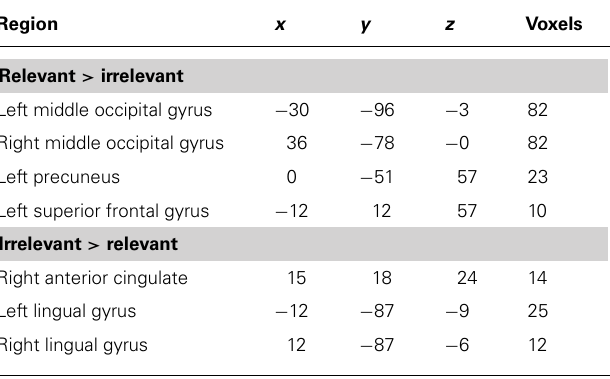
Table 1 | Regions of significant activation in the whole-brain contrast for the spatial localizer